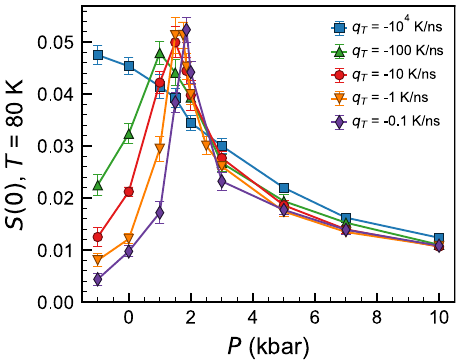
Fig. 2 Cooling rate effects in TIP4P/2005. Long-range limit of the static structure factor ( S (0)) of TIP4P/2005 glasses formed by isobaric cooling to T = 80 K at various pressures ( P ). Colors and symbols denote different cooling rates ( q T ) as marked, and error bars denote 95% con fi dence intervals obtained from the standard error of the